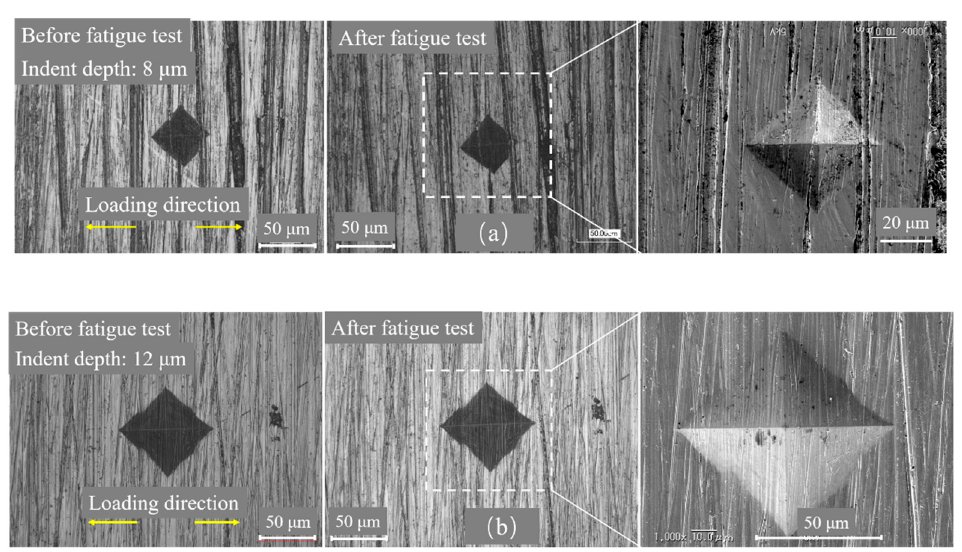
Figure 5. Images of the indents before and after the fatigue test. The crack did not originate from the indent. ( a ) Tested at 220 MPa and failed at 2.57 × 10 7 cycles; ( b ) tested at 220 MPa and failed at 1.25 × 10 7 cycles.